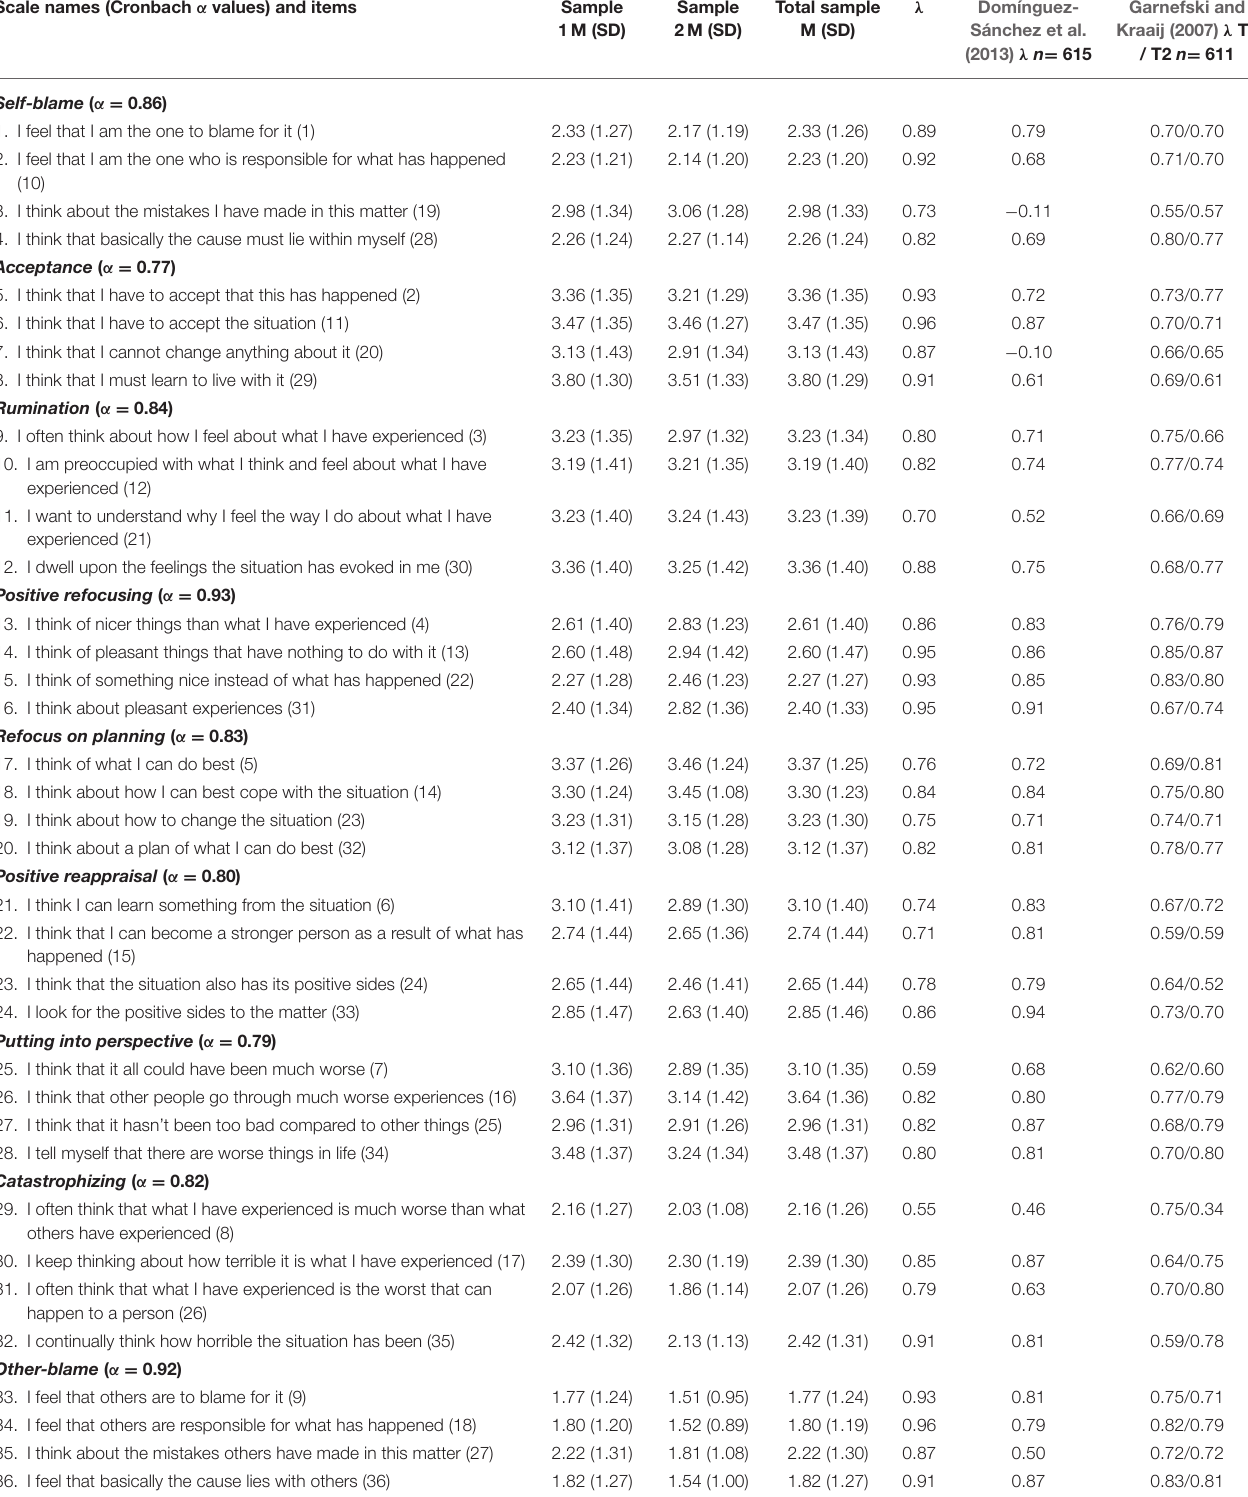
TABLE 2 | Item Content, Mean (M), Standard Deviation (SD), and Factor Loadings ( λ , 9-factor solution) of the CERQ Items. Scale names (Cronbach α values) and